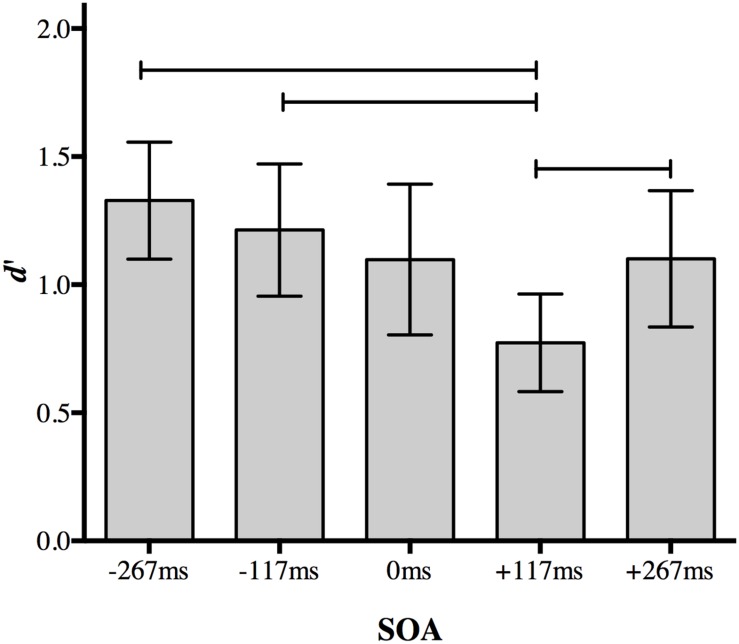
The effect of a foveal distractor on peripheral target discrimination in Experiment 1. A distractor appearing 117 ms after target onset disrupted discrimination more than distractors appearing at non-simultaneous SOAs. Lines indicate statistically significant differences between means after Bonferroni correction for 10 comparisons (p < 0.005). Error bars represent 95% confidence intervals.